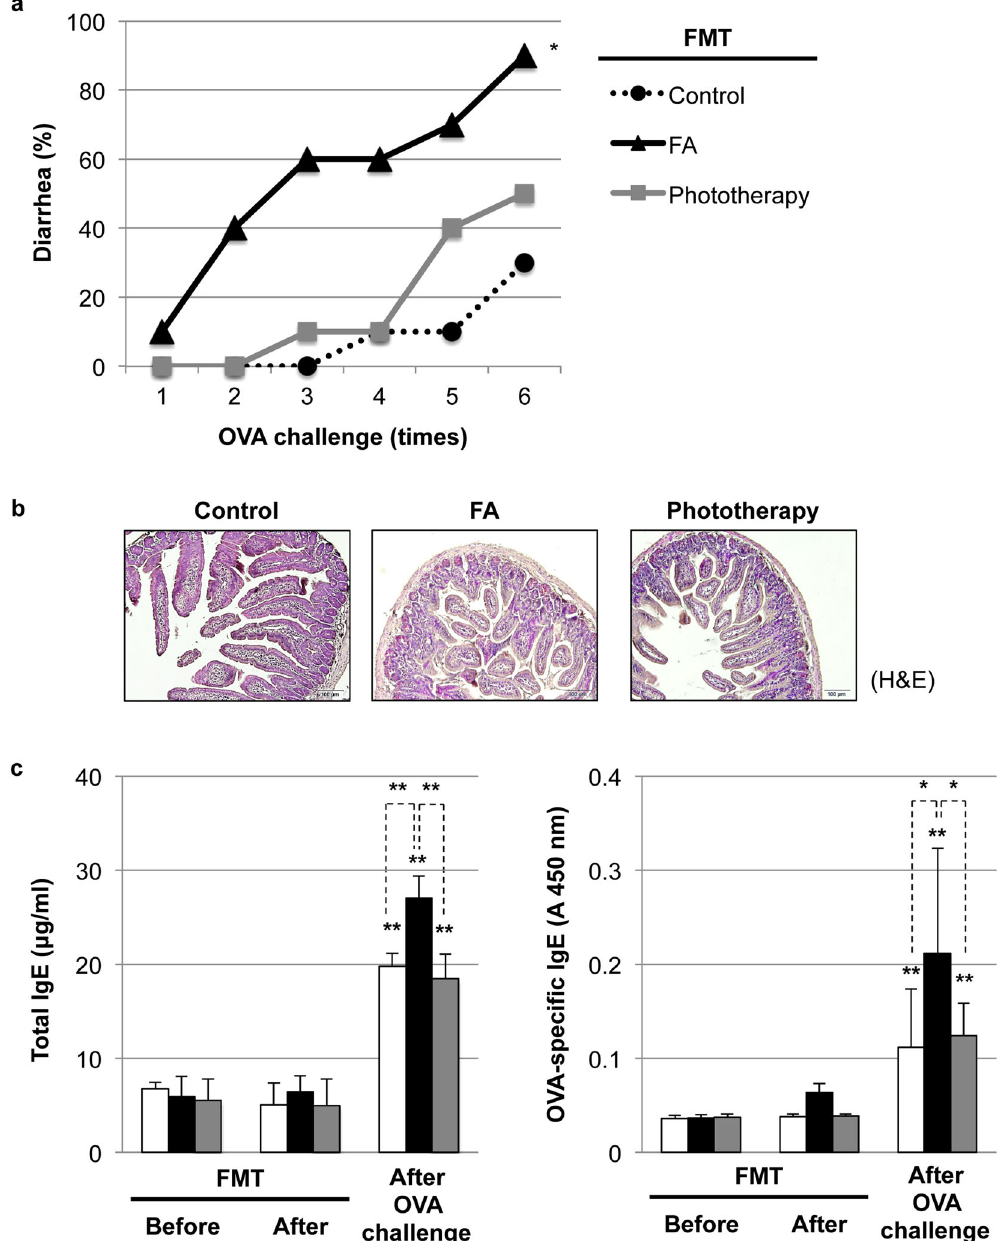
mg/ml feces from control, FA or phototherapy group, n = 10 per group) was given by oral gavage for 3 days. Two weeks after FMT, repeated intragastric (i.g.) OVA challenge was performed, and allergic diarrhea was assessed visually by monitoring mice for 30 min after each i.g. exposure. * P < 0.05 vs. the control-FMT group (Tukey ’ s multiple comparisons test). b Histological evaluation of the intestines of naïve mice with FMT after the 6th OVA challenge. The pictures at ×100 magni fi cation are representative of ten individuals in each group. H&E hematoxylin and eosin staining. Scale bar: 100 μ m. c Elevation of total and OVA-speci fi c IgE after the 6th OVA challenge in FMT mice with donor FA feces (FA-FMT mice, black bar) as compared with the levels in control-FMT (white bar) or phototherapy-FMT (gray bar) mice. Values are presented as the mean ± SD of ten individuals in each group. *, **, P < 0.05 and 0.01 vs. baseline data before FMT or the indicated pair, respectively (Student ’ s t